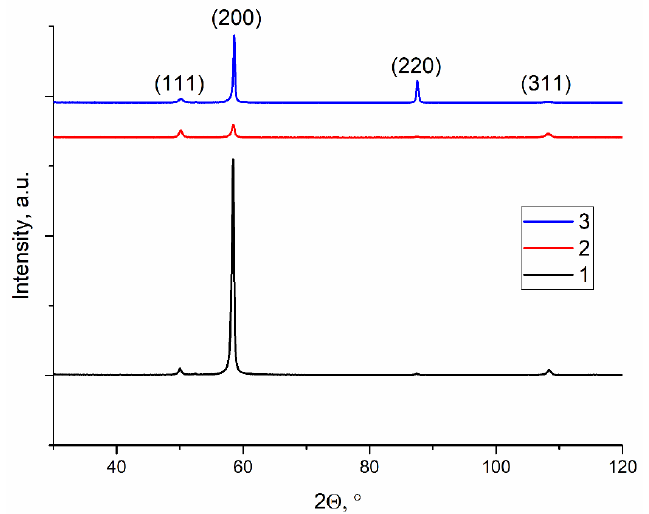
Figure 11. An XRD pattern for the Cu-7.5wt.%Al bronze samples printed at 0.21 kJ/mm (1), 0.255 kJ/mm (2) and 0.3 kJ/mm high (3) heat input.